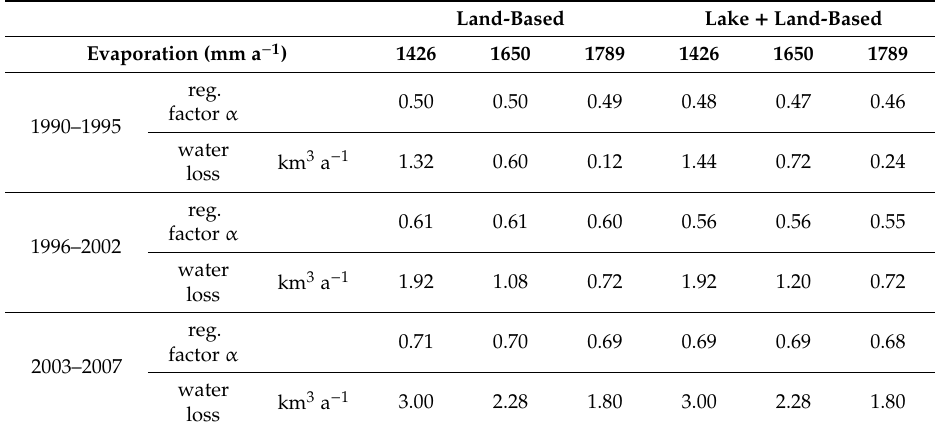
Table 4. Regionalization factor α (defined at the ratio of runo ff per unit area of the ungauged watershed and the gauged watershed in the Lake Tana basin and the unaccounted loss of water in the Lake and surrounding areas for three time periods).